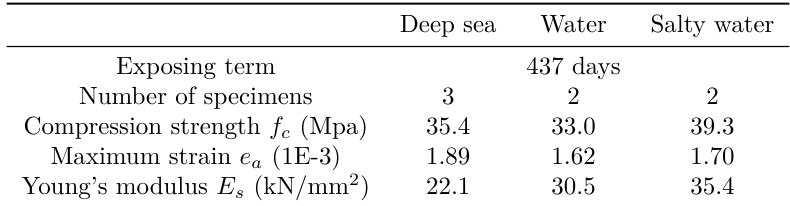
Table 2. Averaged compression test